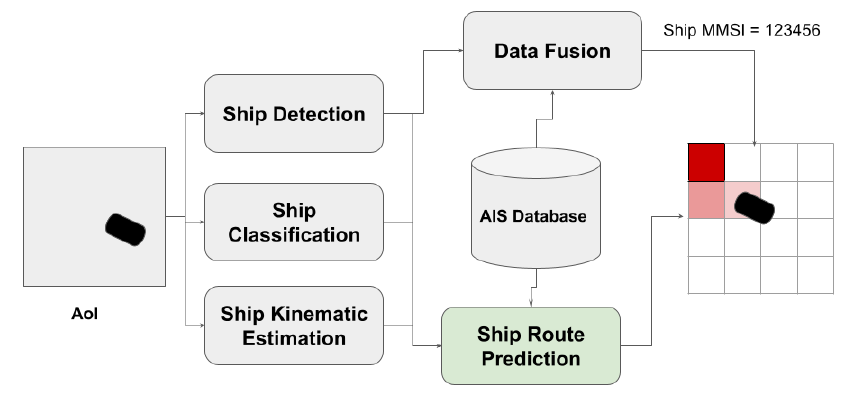
Figure 1. The OSIRIS-FO architecture.